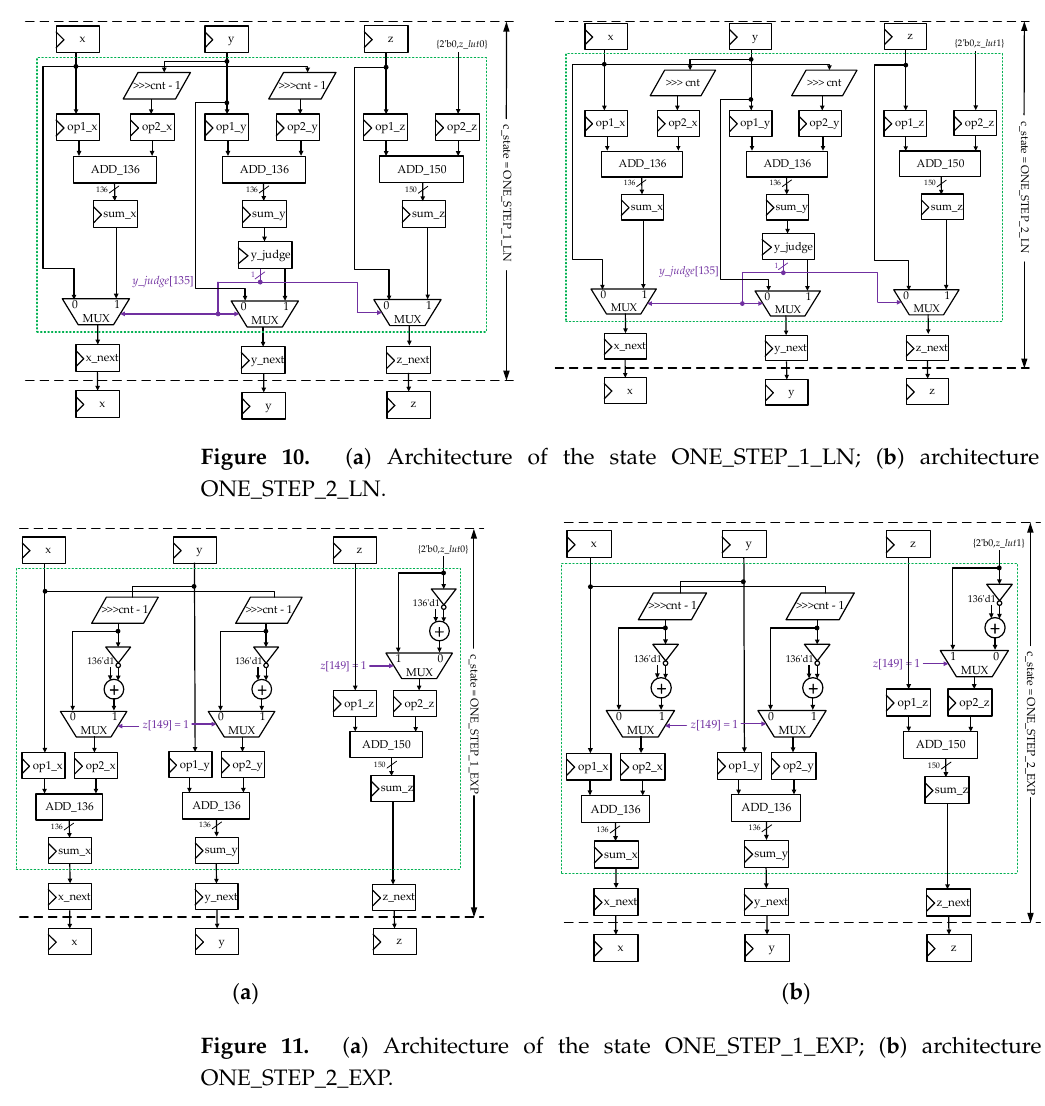
Figure 11. ( a ) Architecture of the state ONE_STEP_1_EXP; ( b ) architecture of the state ONE_STEP_2_EXP.